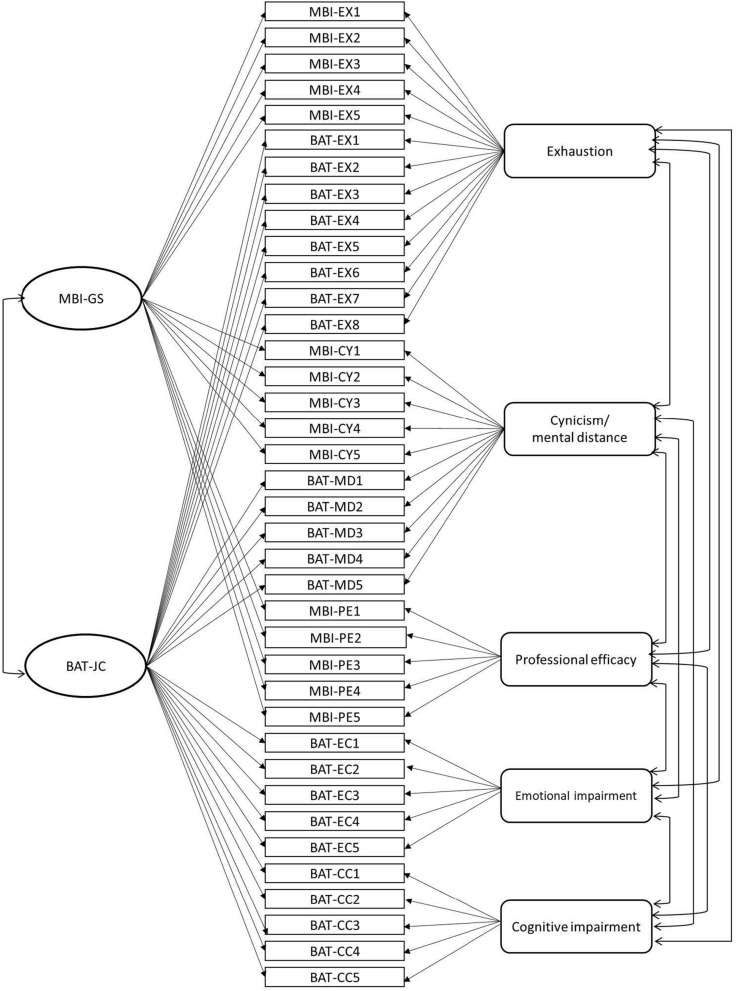
Graphical presentation of the MTMM model, including two method factors (MBI-GS and BAT-JC) and five trait factors (exhaustion, cynicism/mental distance, professional efficacy, emotional impairment, cognitive impairment). MBI-EX1, item 1 of the exhaustion subscale of the MBI-GS; MBI-CY1, item 1 of the cynicism subscale of the MBI-GS; MBI-PE1, item 1 of the professional efficacy subscale of the MBI-GS; BAT-EX1, item 1 of the exhaustion subscale of the BAT-JC; BAT-MD1, item 1 of the mental distance subscale of the BAT-JC; BAT-EC1, item 1 of the emotional impairment subscale of the BAT-JC; BAT-CC1, item 1 of the cognitive impairment subscale of the BAT-JC.